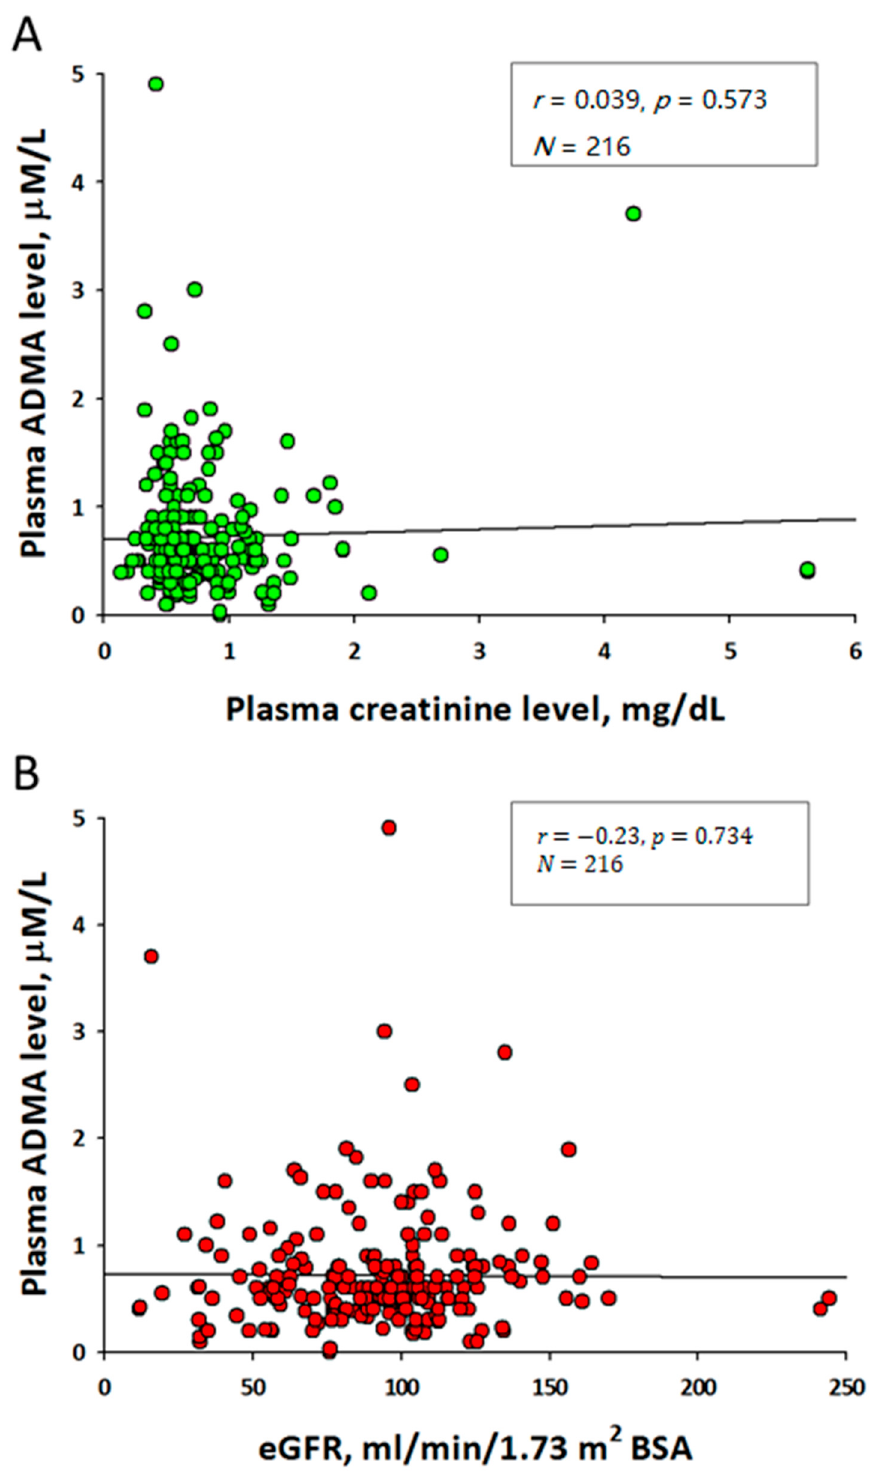
Figure 2. Person correlation and linear regression analyses between plasma ADMA level and ( A ) plasma creatinine level and ( B ) estimated glomerular filtration rate (eGFR) in 216 CKD stage 1–4